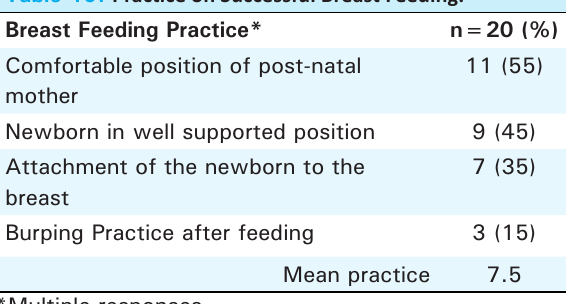
Table 8. Knowledge on Newborn’s Hygiene Care.